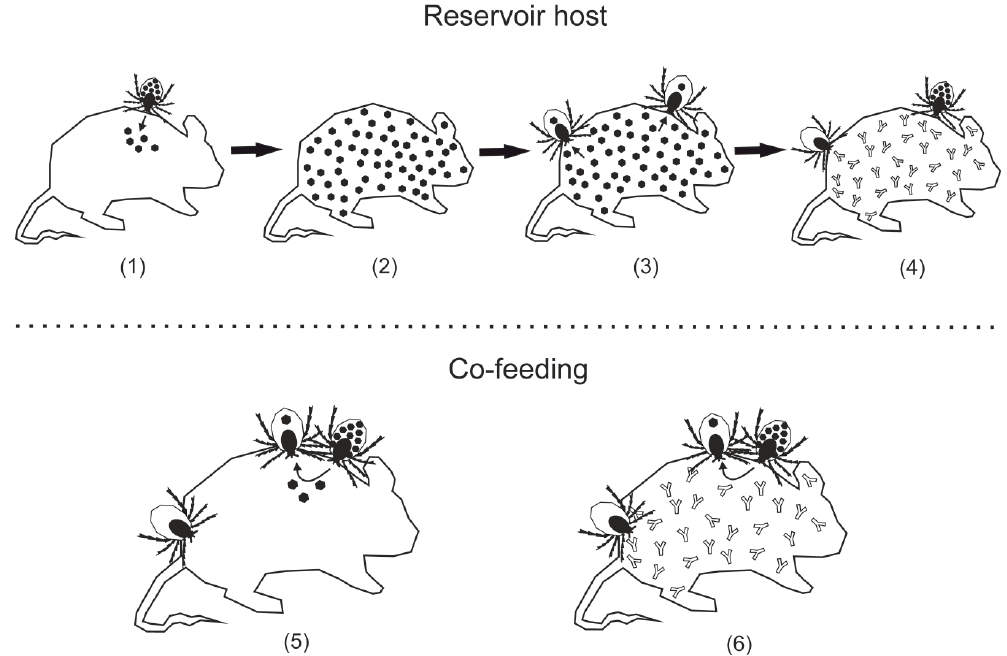
Figure 2. TBEV reservoir hosts: Small mammals, especially rodents, are considered to be reservoir hosts for TBEV. Infected ticks transmit the virus ( ) to the animal host ( 1 ), leading to viremia ( 2 ).